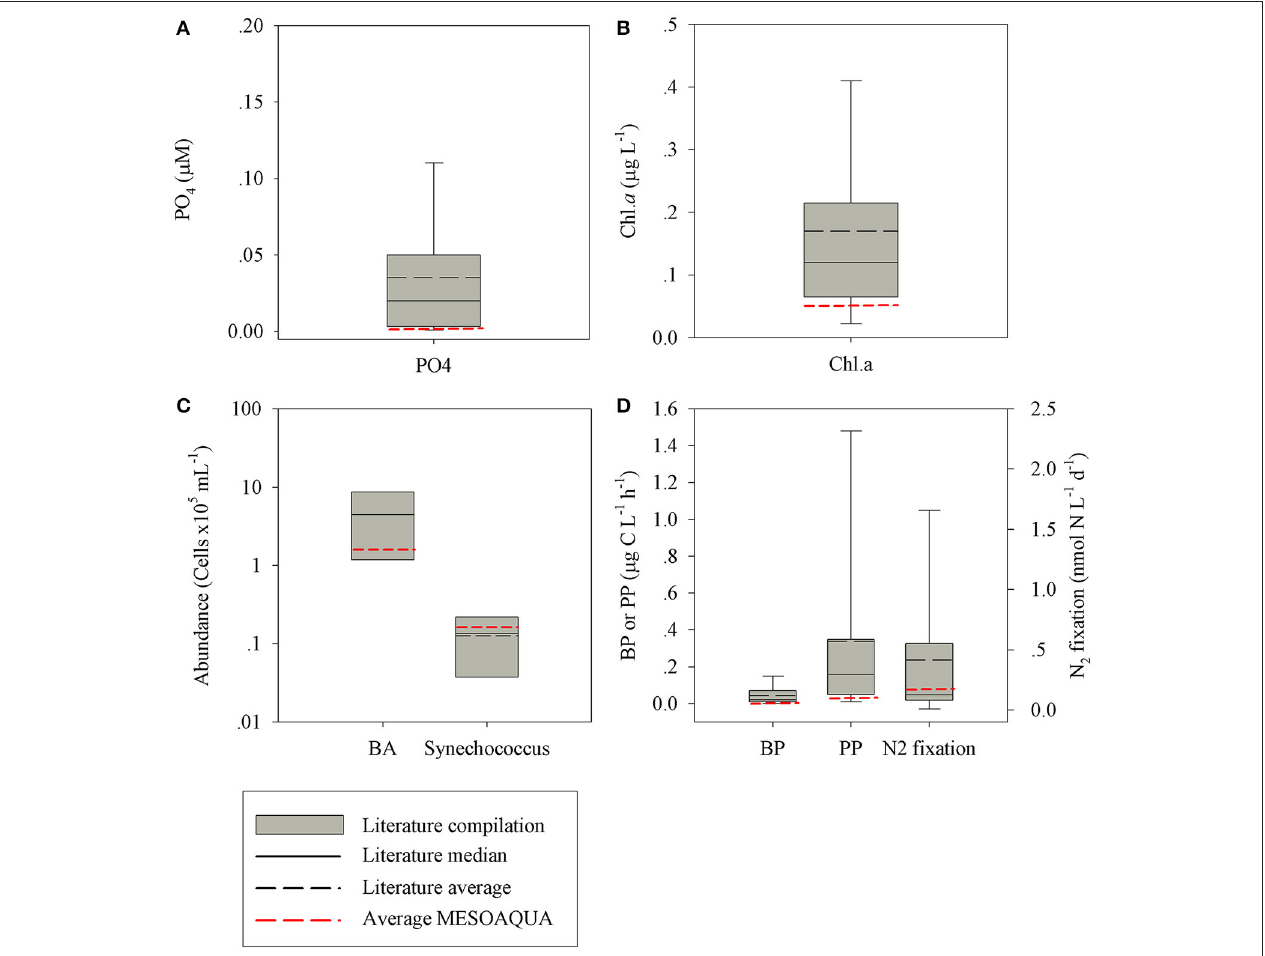
FIGURE 3 | A box plot distribution of phosphorus (A), chl- a (B) , microbial cell abundances (C) , and microbial production rates (D) , as reported for oligotrophic marine environments worldwide ( Azov, 1986; Zohary and Robarts, 1998; Herut et al., 2000; Pinhassi and Hagström, 2000; Ignatiades et al., 2002; Wu et al., 2003; Krom et al., 2005; Pulido-Villena et al., 2008; Foster et al., 2009; Fernández et al., 2010; Christaki et al., 2011; Van Wambeke et al., 2011; Watkins-Brandt et al., 2011; Moisander et al., 2012; Rahav et al., 2013, 2015, 2016b; Tanhua et al., 2013; Kress et al., 2014; Keuter et al., 2015; Raveh et al., 2015; Tsiola et al., 2016). The black line represents the median (solid) and average (dashed) value. In red: the average values measured during this study